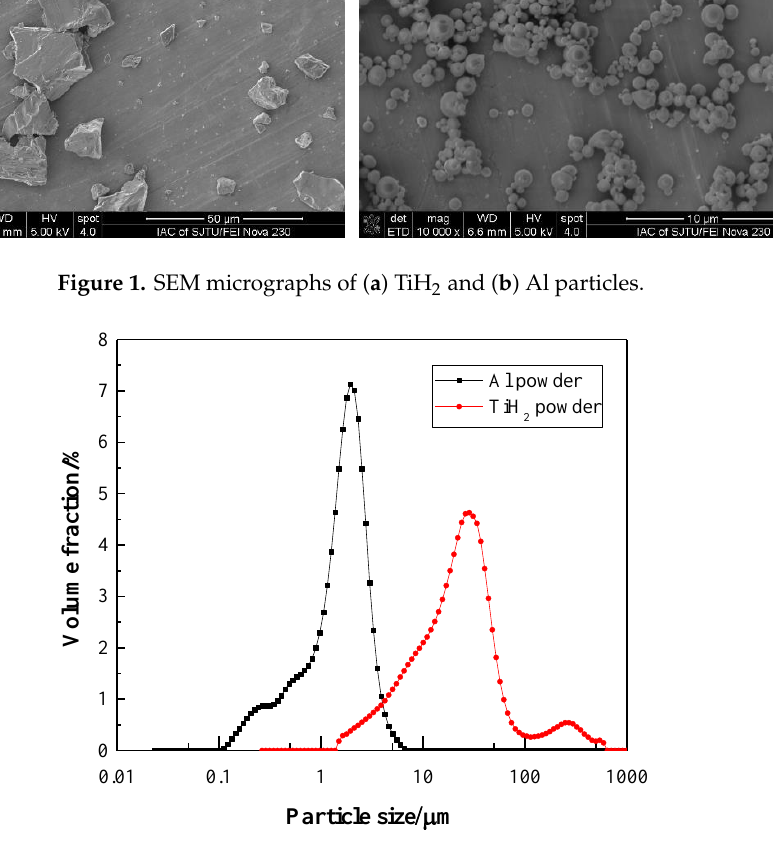
Figure 2. Size distribution curves of TiH 2 and Al Powders.